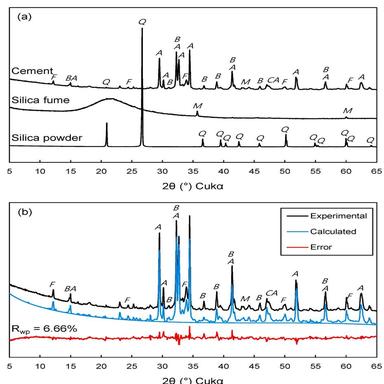
X-ray diffractograms of (a) raw materials and (b) Rietveld analysis result of raw cement. The annotations indicate the following: F—brownmillerite, BA—basanite, A—alite, B—belite, M—periclase, CA—calcium aluminate, and Q—quartz.